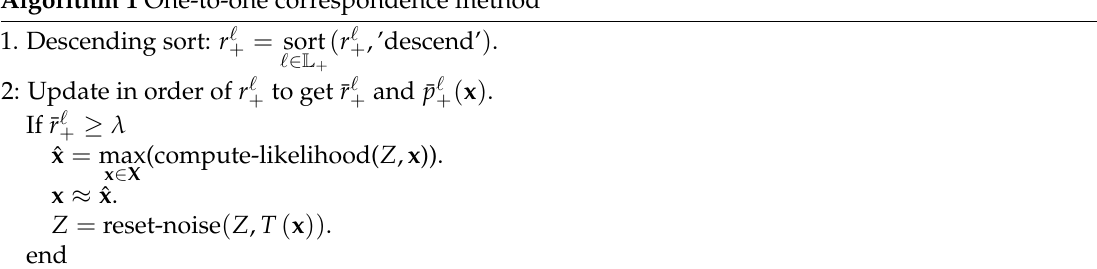
Algorithm 1 One-to-one correspondence method